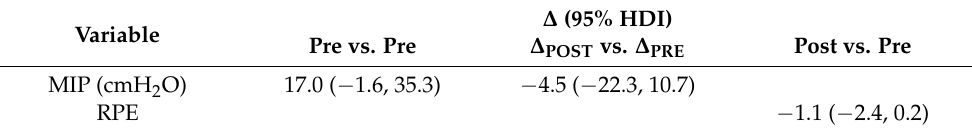
Table 6. Between-group differences in the increments in MIP and RPE values.